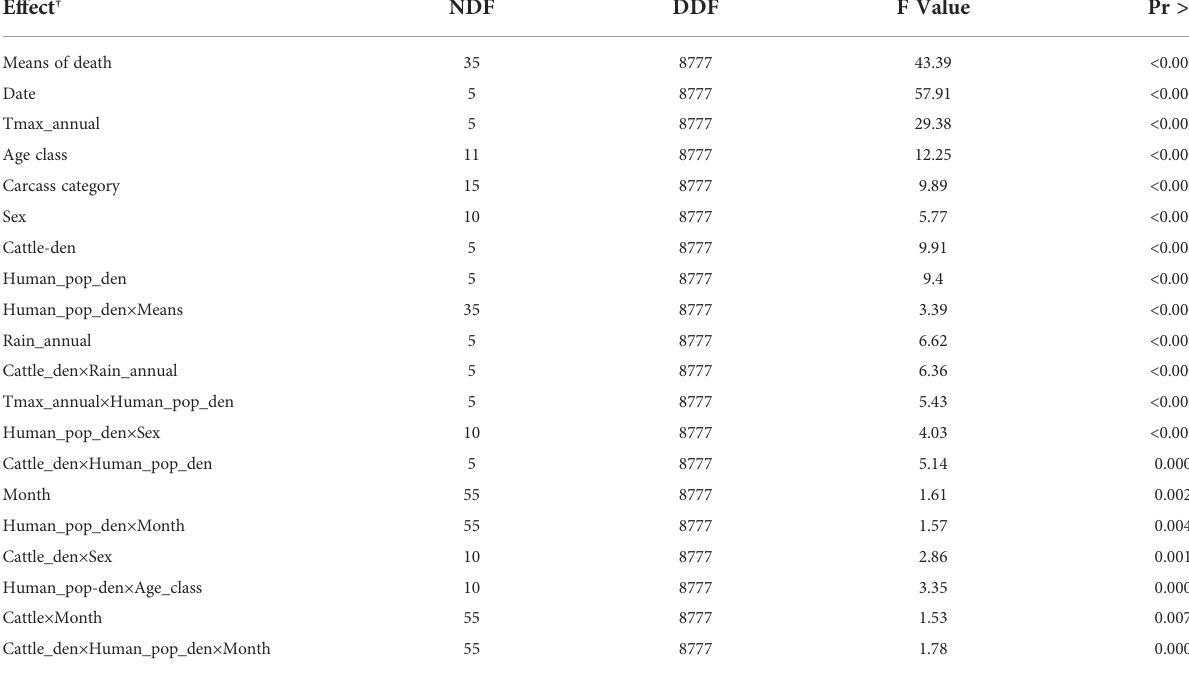
TABLE 3 F tests of signi fi cance of effects retained in the fi nal model relating elephant mortality probability (cause of death=ivory hunting set as the baseline category) to predictor variables and their interactions. Effect